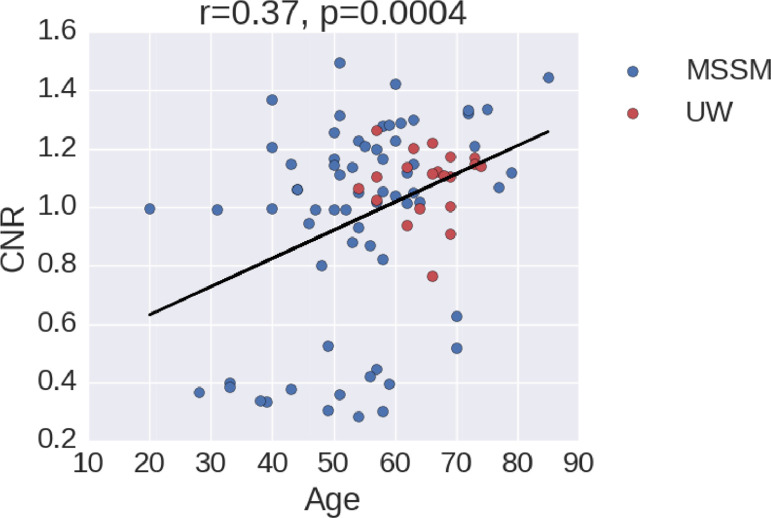
Age versus CNR for the subjects at each institution: Mount Sinai School of Medicine (MSSM; blue dots) and University of Washington (UW; red dots). The black line shows the linear regression of all the points, with r = 0.37 and p-value < 0.001. Here CNR was computed as the average of white/gray matter and gray matter/cerebrospinal fluid contrasts, averaged across hemispheres. More details on CNR calculation are available at https://github.com/ComaRecoveryLab/Lesion_Correction.